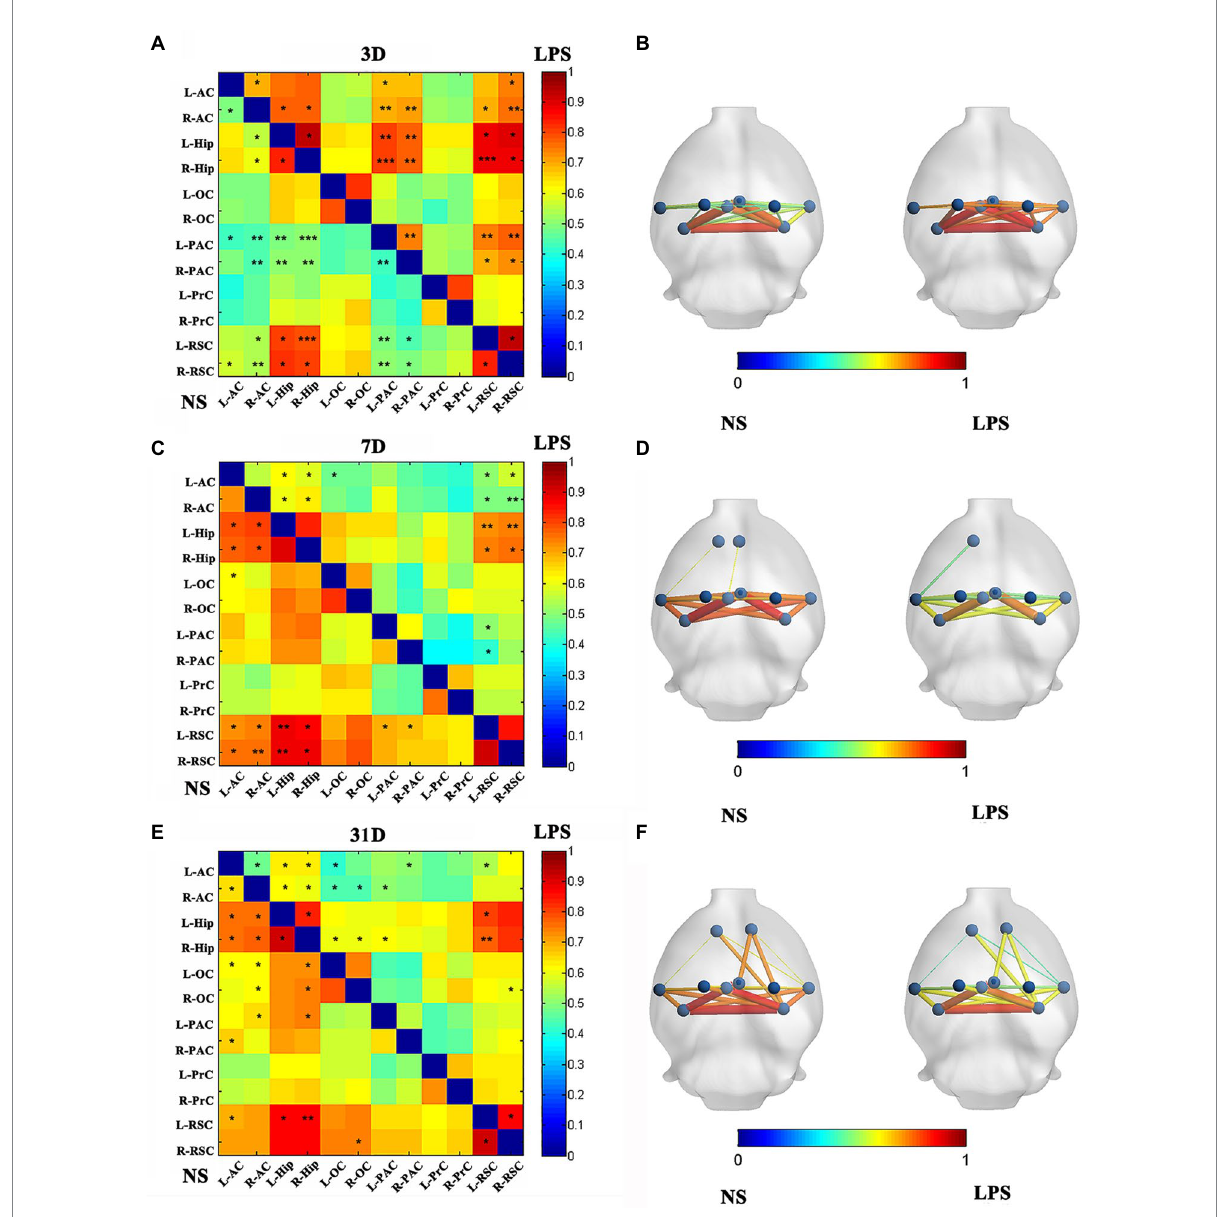
FIGURE 5 Functional connectivity (FC) in rats with lipopolysaccharide (LPS) exposure compared with control group. (A,B) FC value, nodes, and edges position in rats receiving LPS exposure (right) and control group (left) on day 3 after LPS exposure. (C,D) FC value, nodes, and edges position in rats receiving LPS exposure (right) and control group (left) on day 7 after treatment. (E,F) FC value, nodes, and edges position in rats receiving LPS exposure (right) and control group (left) on day 31 after treatment. Data were analyzed using two-sample t -test with network-based analysis correction (permutation 1,000 times). * p < 0.05, ** p < 0.01, *** p < 0.001 vs. control